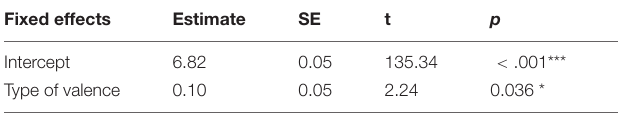
TABLE 4 | Model parameters for the best-fitting model for RTs in Experiment 1.